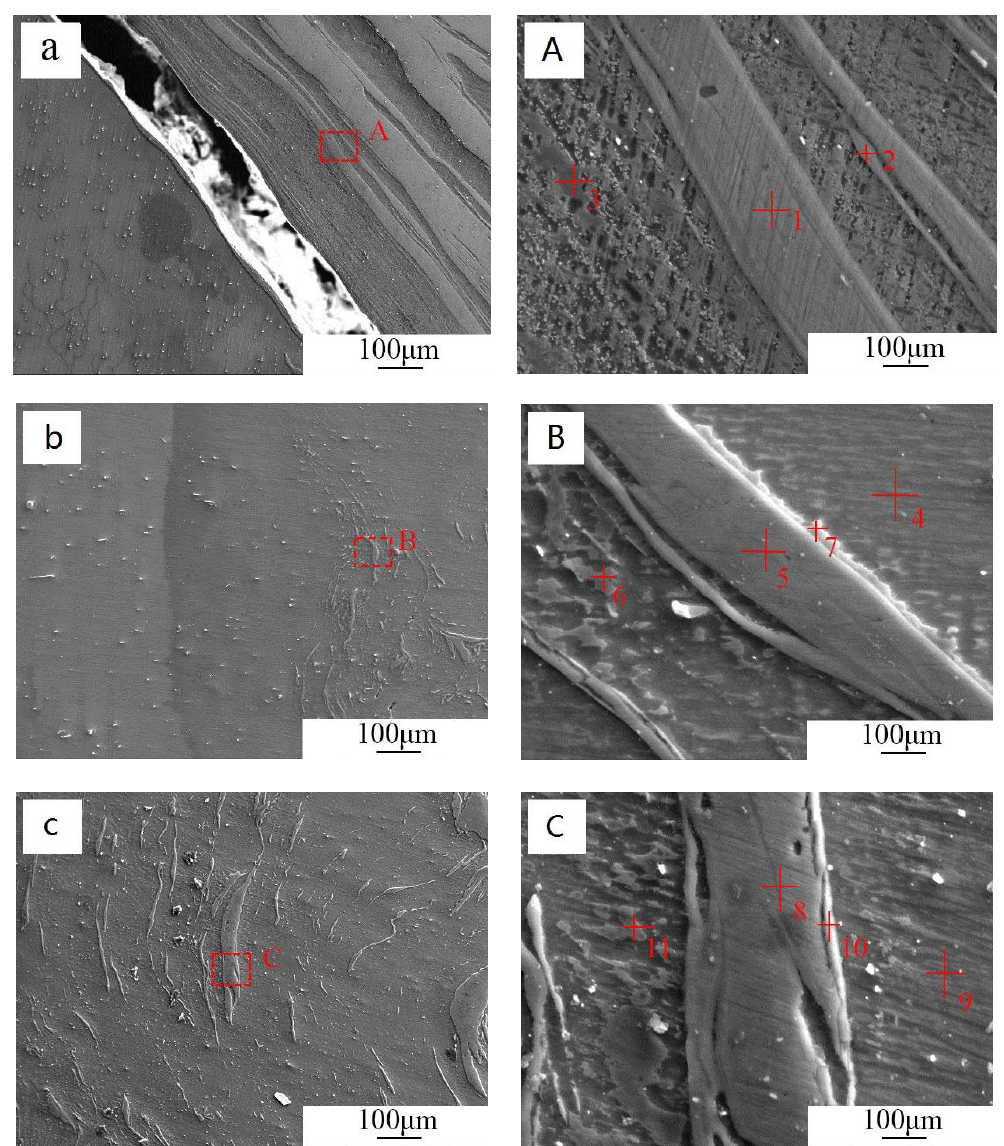
Figure 5. Morphologies near the interface of the sample: ( a ) T2, ( b ) T5, ( c ) T7,( A ) magnification of T2, ( B ) magnification of T5, ( C ) magnification of T7. Table 3. EPMA analysis of T2, T5 and T7 (wt%).